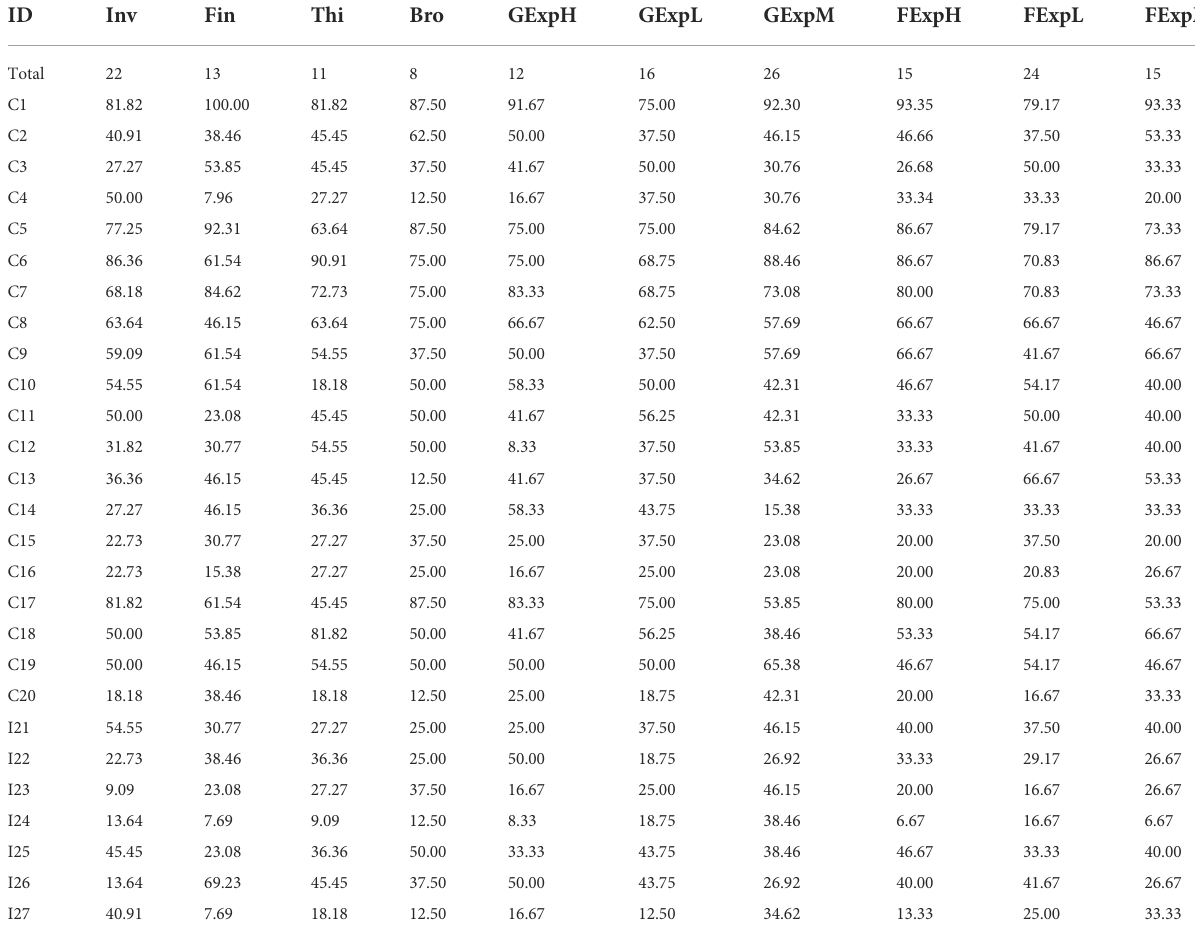
TABLE 4 Voting results of different groups towards 20 challenges and 7 desire improvements highlighted by questionaries. The Total row illustrates the number of respondents in each group. The rows C1 to I27 represent the percentages (%) of respondents from each